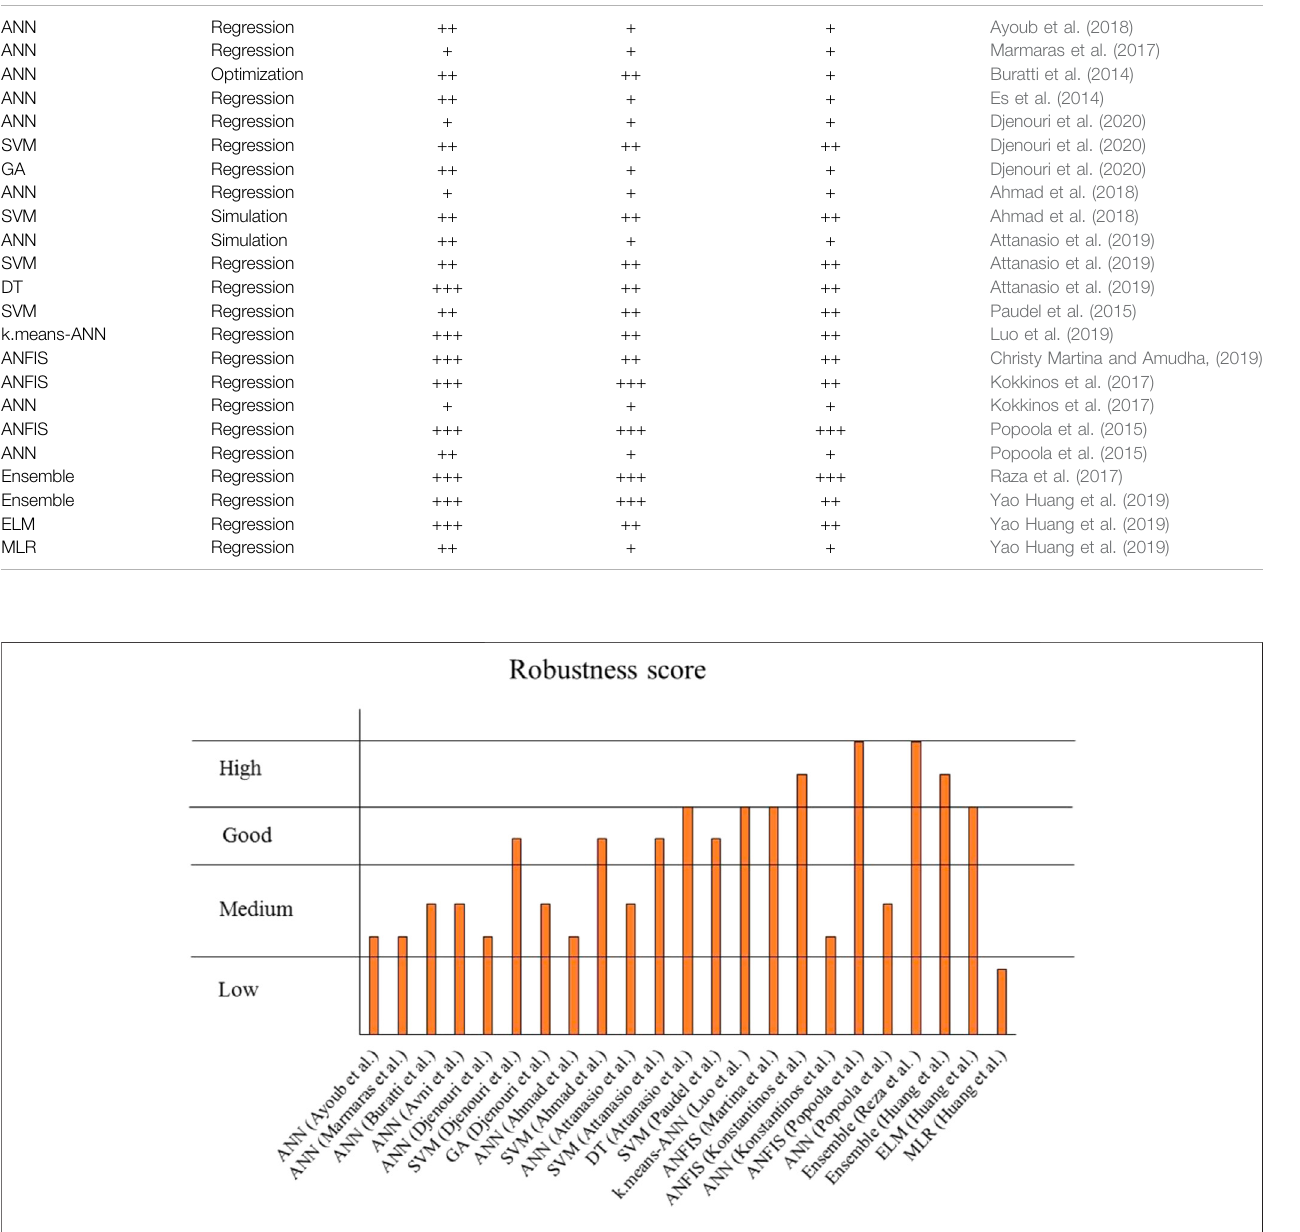
FIGURE 6 | Robustness score for energy demand forecasting